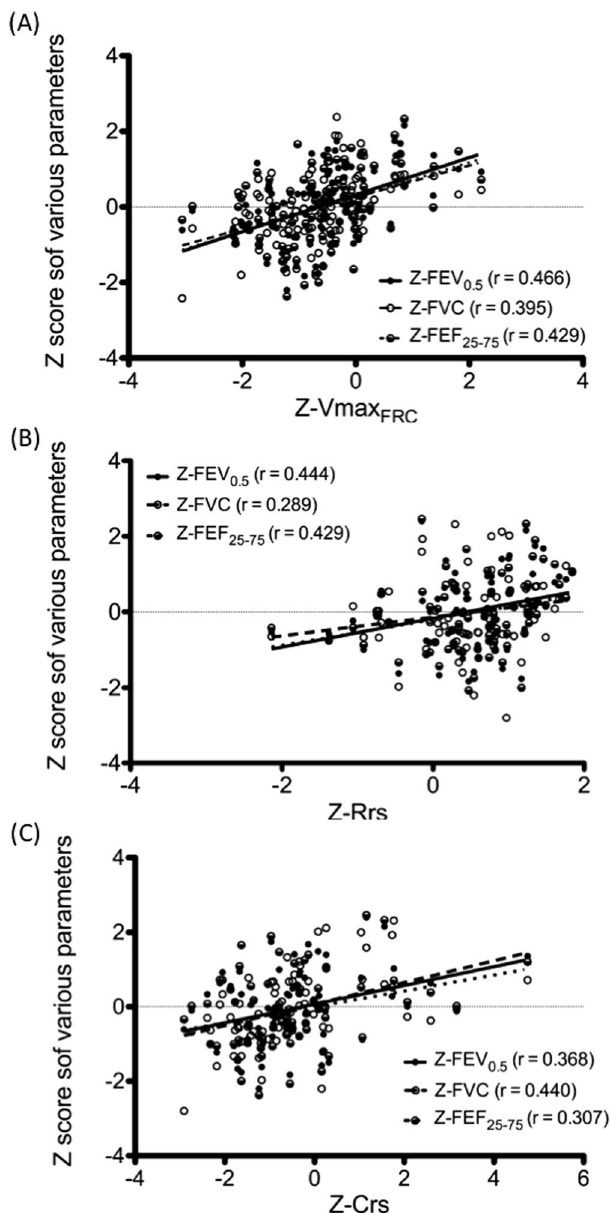
Figure 2. Scatter plots and regression curves of Z-scores of infant lung function parameters. Z-scores of the maximal expiratory flow measured in functional residual capacity (Vmax FRC ) ( A ), resistance of the respiratory system (Rrs) ( B ), and compliance of the respiratory system (Crs) plotted against the Z-scores of various RVRTC parameters including forced expiratory volume at 0.5 (FEV 0.5 ), forced vital capacity (FVC), and forced midexpiratory flow (FEF 25–75